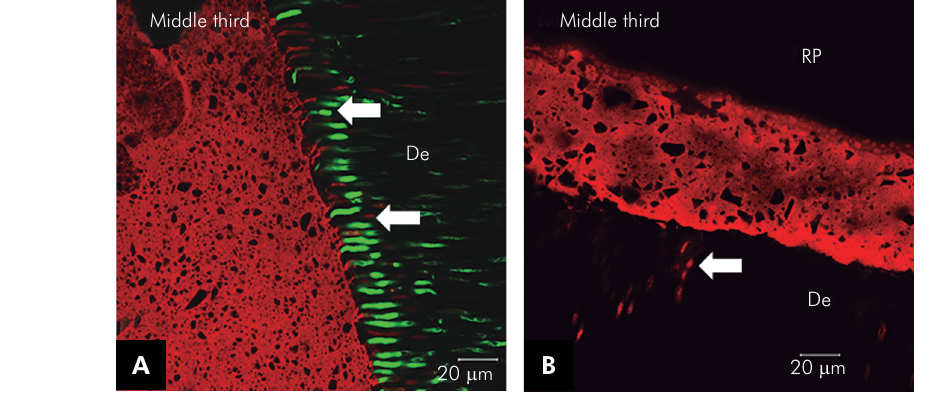
Figure 3. CLSM images (63x) of the interface between the relined fiberglass post and root dentin using RelyX ARC (3A) and RelyX U200 (3B). Green color: Adper Scotchbond Multi-Purpose Plus Adhesive (activator, primer and catalyst). Red color: resin cement. RP: relined fiberglass post; De: dentin. (3A) The presence of tags from both the adhesive system and the resin cement (arrows) are observed. (3B) The image demonstrates the penetration of the RelyX U200 resin cement into the dentinal tubules forming resin tags